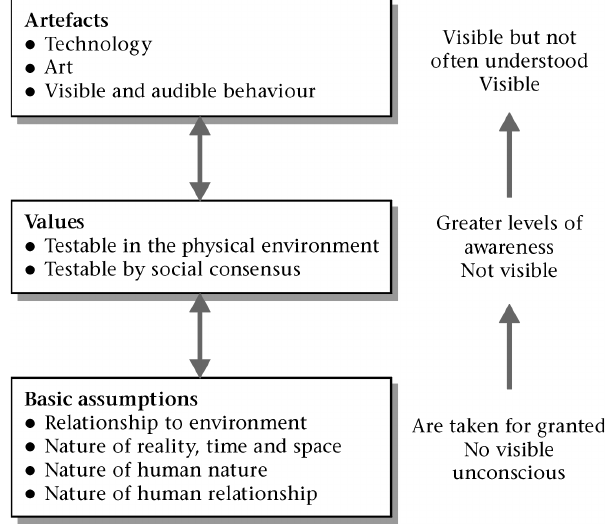
Figure 1: Schein’s model of organisational